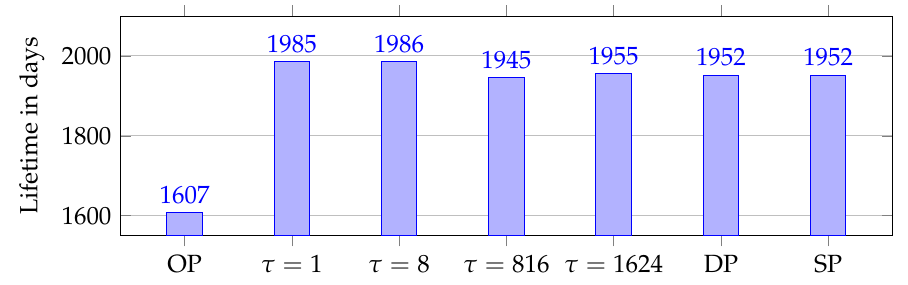
Figure 13. Lowest node lifetime for the different